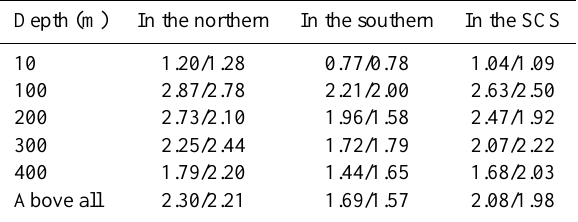
Table 2. Comparisons of the temperature RMSEs in Ctrl/Assim at different depths by the EN3 temperature profiles in the 8 months during 1994–1995. All the temperature observations in the SCS can be divided into two regions: in the northern and in the southern with respect to 13 ◦ N. Depth